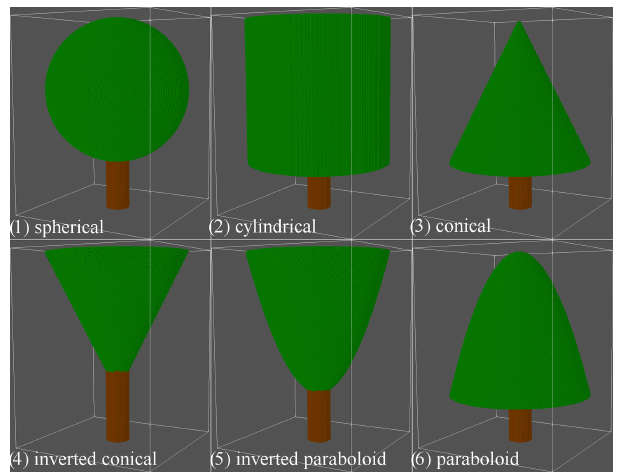
Figure 14. Overview of tree shapes available in the single-tree canopy generator. Green surfaces represent the foliage while brown surfaces represent the tree trunk. The shown sketches were created for a raster size of 0.05m using a tree height of 8m, a crown width of 6m, a crown height to width ratio of 1 and a trunk diameter of